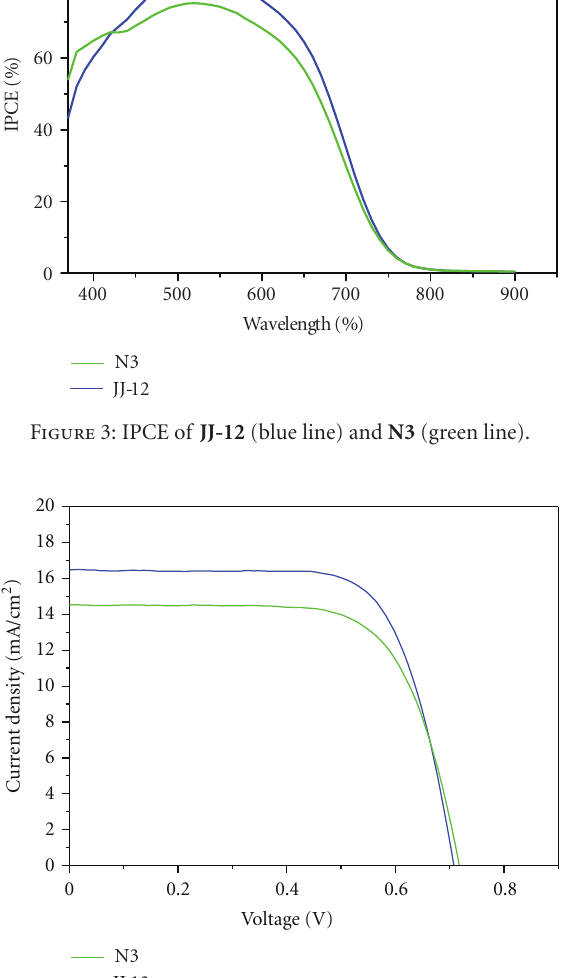
same condition. The JJ-12 sensitizer’s IPCE spectrum is more enhanced in 420–740 nm range compared to that of N3 as a result of extended π -conjugation of fused triphenylamine ring, which is consistent with the absorption spectrum of JJ- 12 .